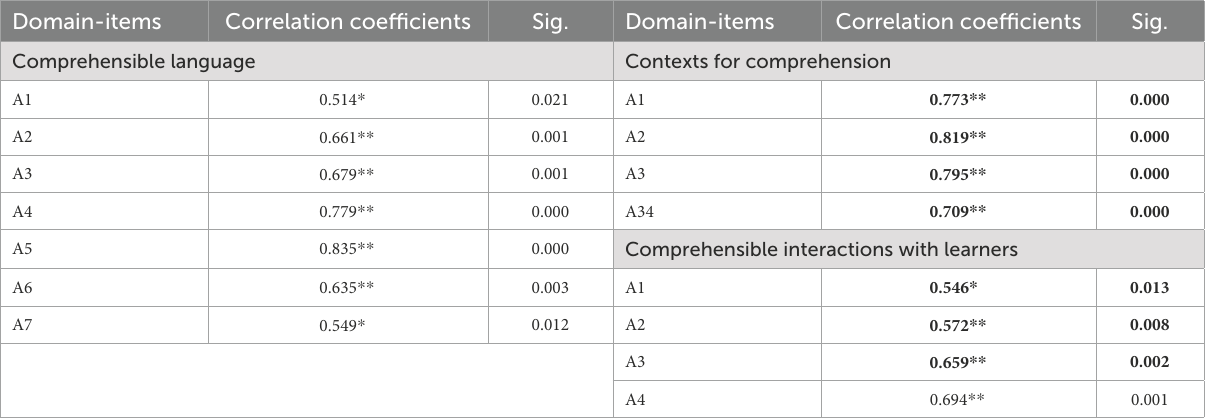
TABLE 3 Pearson correlation coefficients for items and their